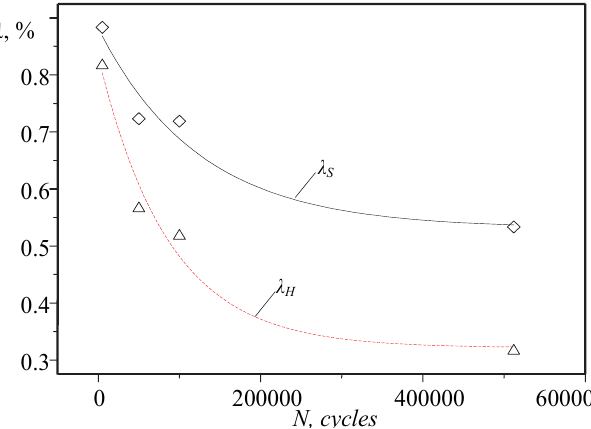
Figure 4: Dependence of the relative damage indicators λ S and λ H versus the number loading cycles of the